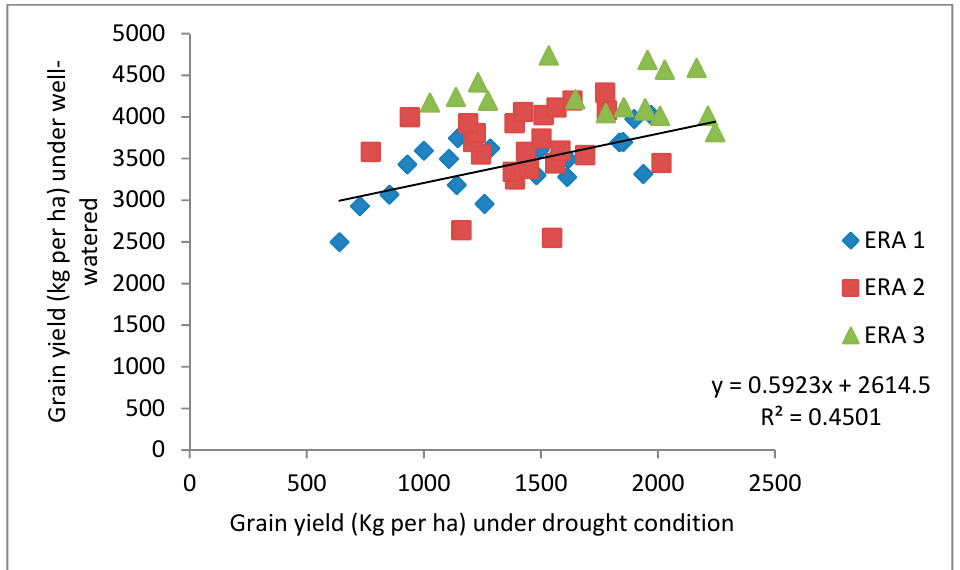
Figure 1. Performance of extra-early maize hybrids of three breeding periods under drought con- ditions versus rainfed conditions.